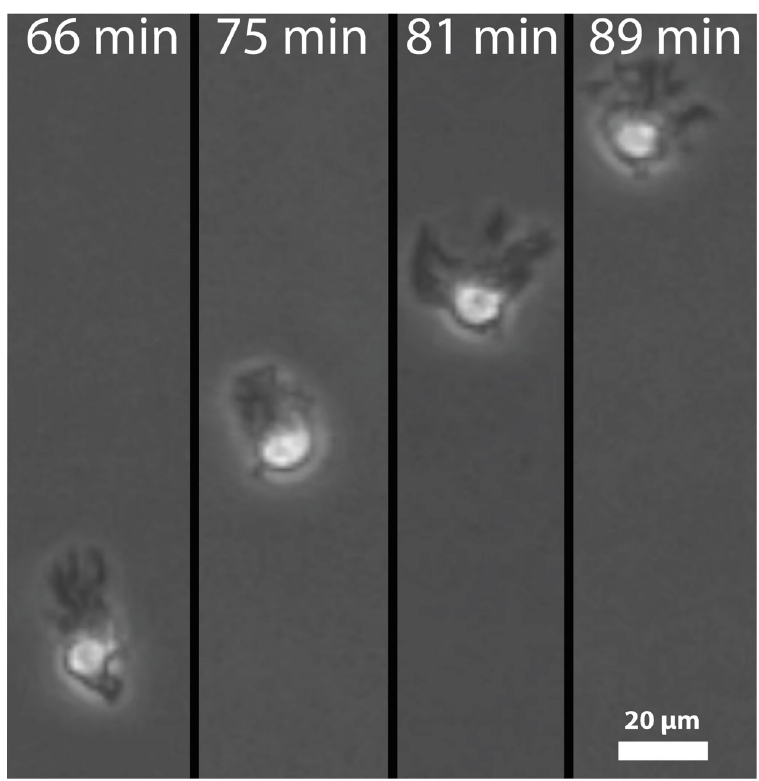
Fig 1. DCs crawl up chemokine gradients by focusing their filopodia along their direction of motion. Screenshots were taken from videos used for calculations by Ricart et al .